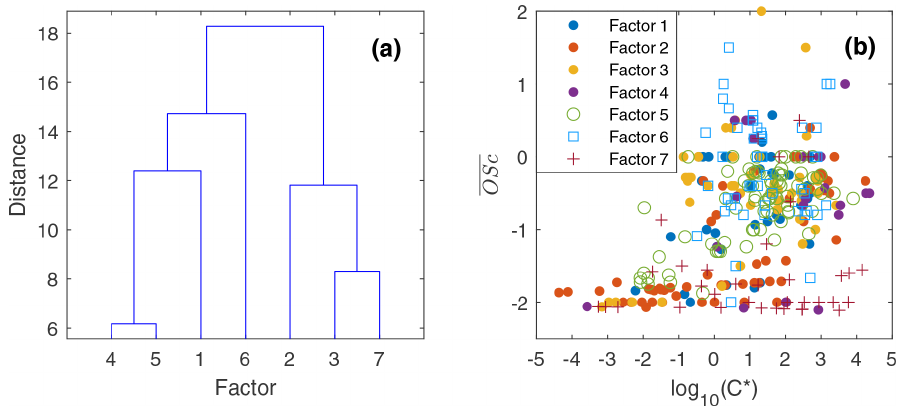
Figure 7. (a) Hierarchical clustering relationship. (b) Effective saturation concentration versus OS c of compounds colored by factor number.